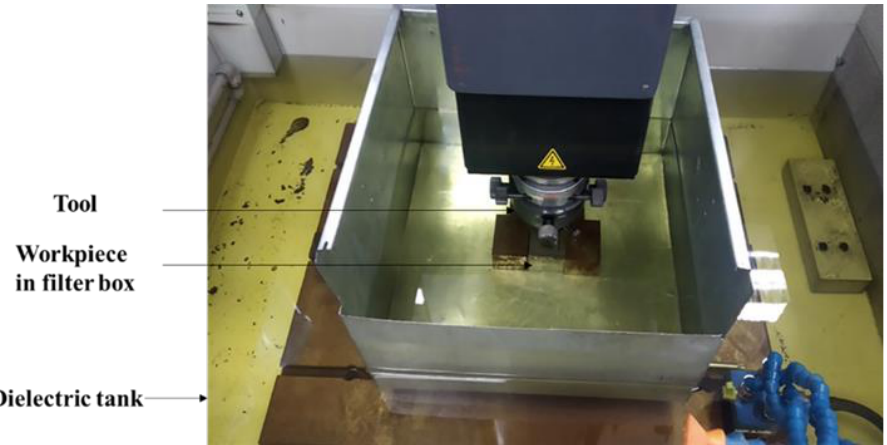
Figure 3. Workpiece emerged with an oleic acid